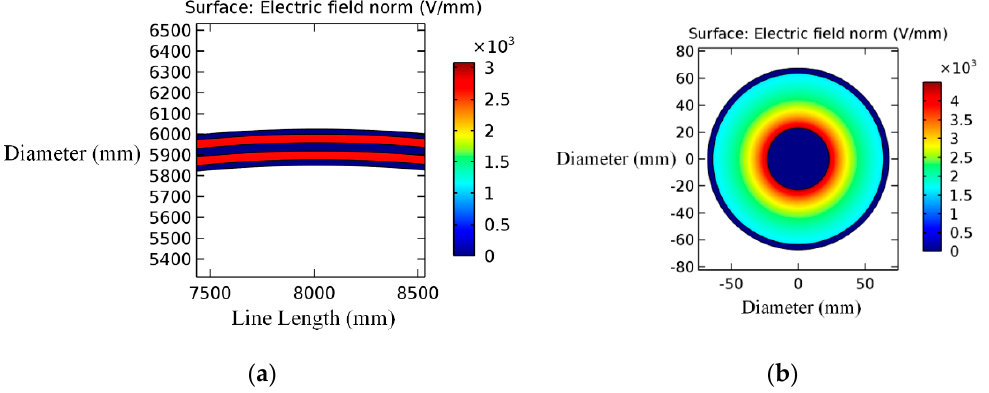
Figure 20. Electrostatic field distribution in bended segment of proposed PE 100 based FGIL scheme regarding ( a ) axial and ( b ) radial cross-sections.